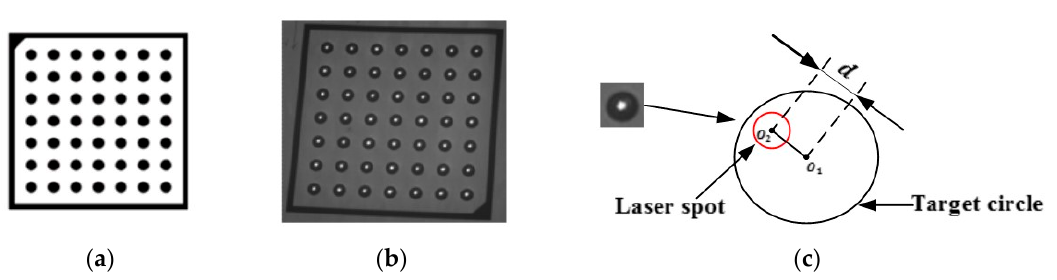
Figure 6. Design of target shooting experiment. ( a ) The pattern of target circles. ( b ) Experiment result of target shooting. ( c ) The distance between the centers of laser spot and target circle.